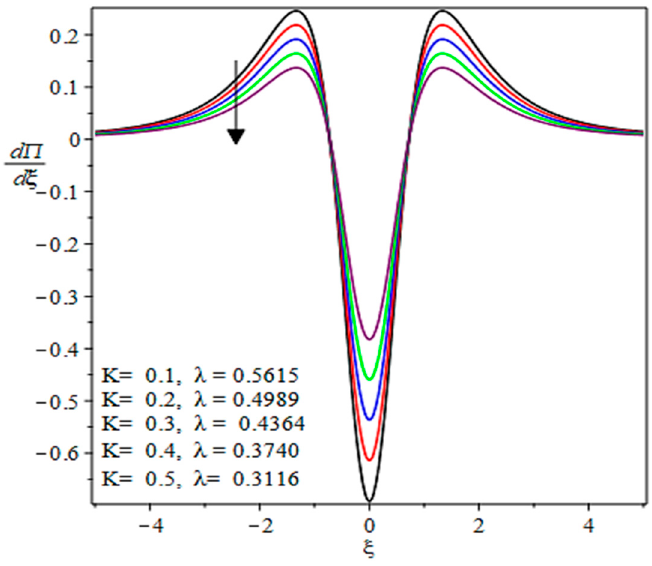
Figure 10. Viscoplastic parameter ζ influence on the velocity profile at ξ = 0.75 by fixing K = 0.1, M = 1.